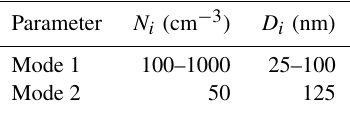
Table 4. Range of values assigned to the number concentration, N i , and involatile particle diameter, D i , used in the dynamic model sim-